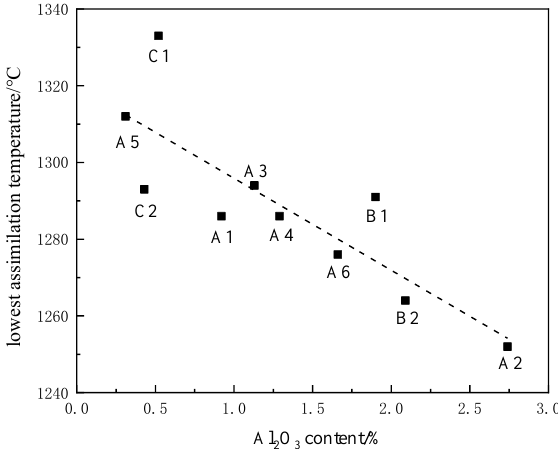
and the formation of a composite calcium ferrite binder phase in sinter is promoted. When the iron ore powder used in the experiment was optimized, when the Al 2 O 3 content of the ore powder was less than 0.3%, the assimilation performance of the mixed ore was improved by increasing the Al 2 O 3 content.